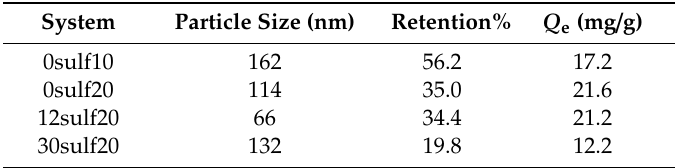
Table 3. E ff ect of sulfonate groups and OADA amount, used in the polymerization reaction, on the surfactant retention capacity of